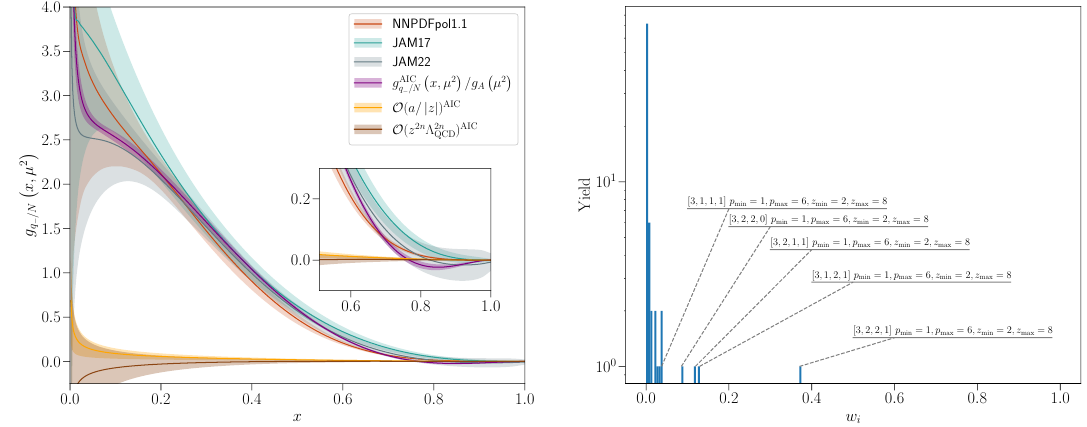
(cid:0) (cid:1) ν, z 2 cut on p latt ∈ [1 , 6] and (cid:0) (cid:1) z 2 n Λ 2 n higher-twist (brown) QCD